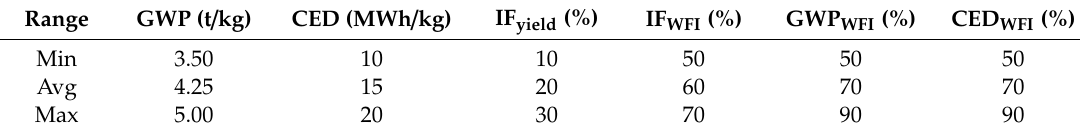
Table 2. Reference monoclonal antibody (mAb) process impact factors, possible process improvements and their e ff ect on impact factors investigated in this study. Improvement factor (IF), global warming potential (GWP), cumulative energy demand (CED), water for injection (WFI). Range GWP (t / kg) CED (MWh / kg) IF yield